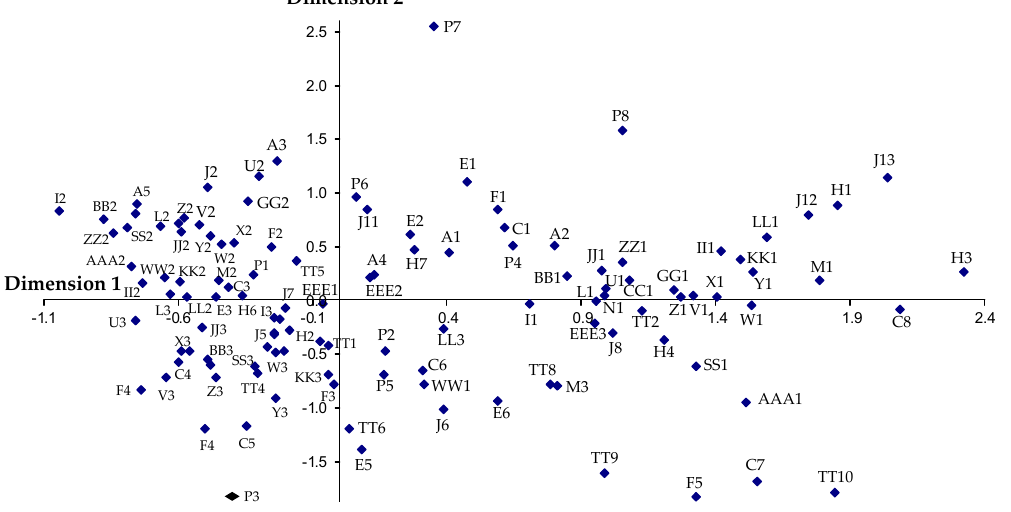
Figure 2. Factorial plane of the quantifications of the variable categories.